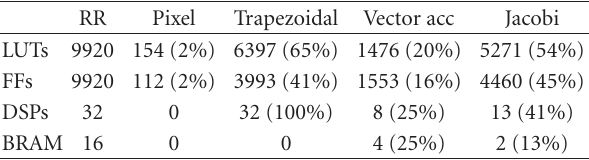
Table 2: Resource utilization of four application hardware engines (Percentages are relative to the